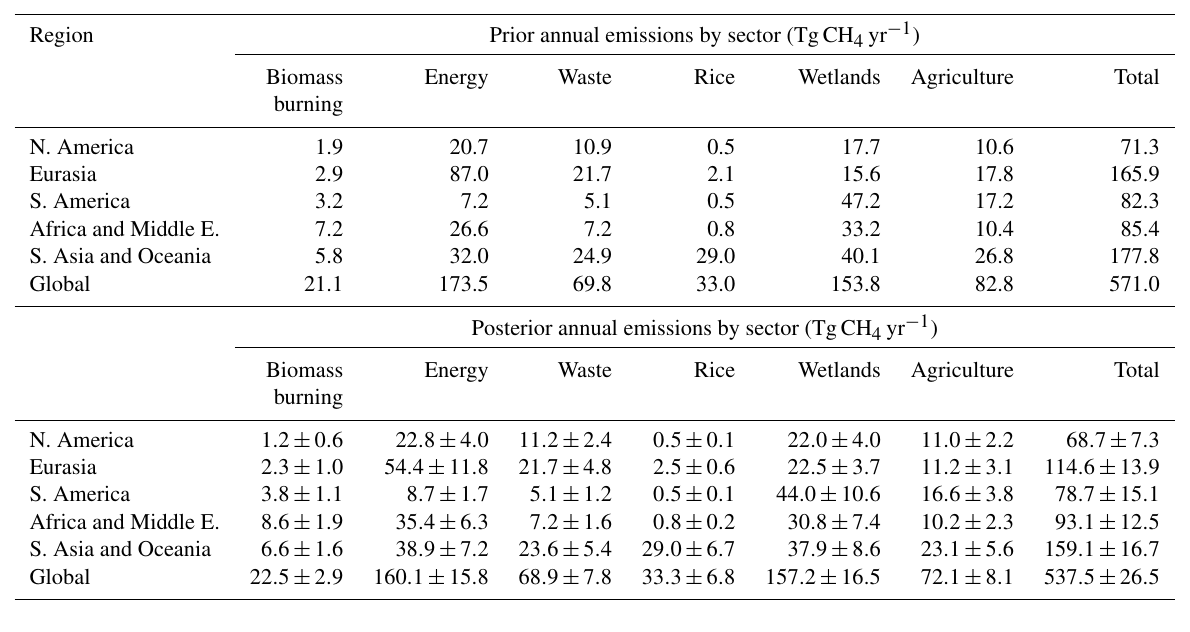
Table 4. Regional CH 4 emissions based on prior (top) and synthesis inversion estimates (bottom) between 2003 and 2015. Note the total global emissions, but not the total regional emissions, include the supplementary emissions (geological, hydrates, oceans, and termites). Uncertainties are also shown for posterior emissions; all prior emissions have a 50%